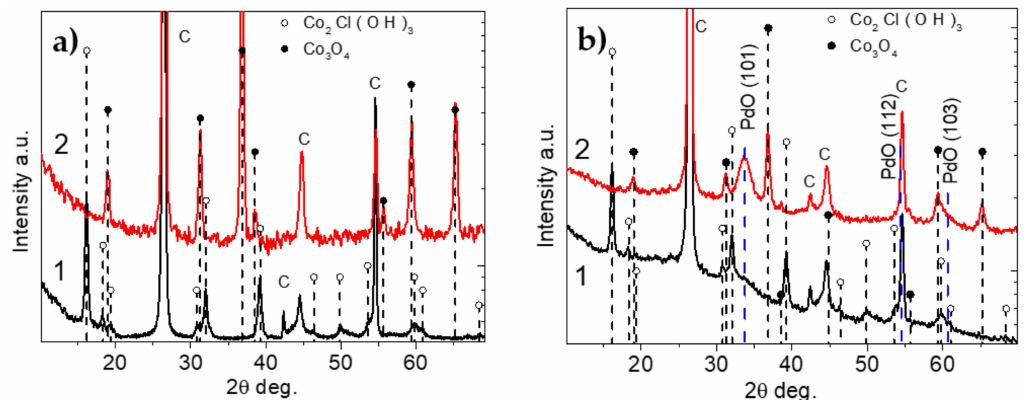
Figure 2. X-ray diffractograms for prepared samples. Pattern 1, immediately after synthesis: Co 3 O 4 /C ( a ), Pd-Cl 2 -Co 3 O 4 /C ( b ); Pattern 2, after annealing at a temperature of 400 ◦ C for 3 h: Co 3 O 4 /C-T ( a ), PdOCo 3 O 4 /C ( b ). Table 2. The size of Pd, Co, and Pt crystallites (XRD) and particles (TEM) in the investigated catalysts.